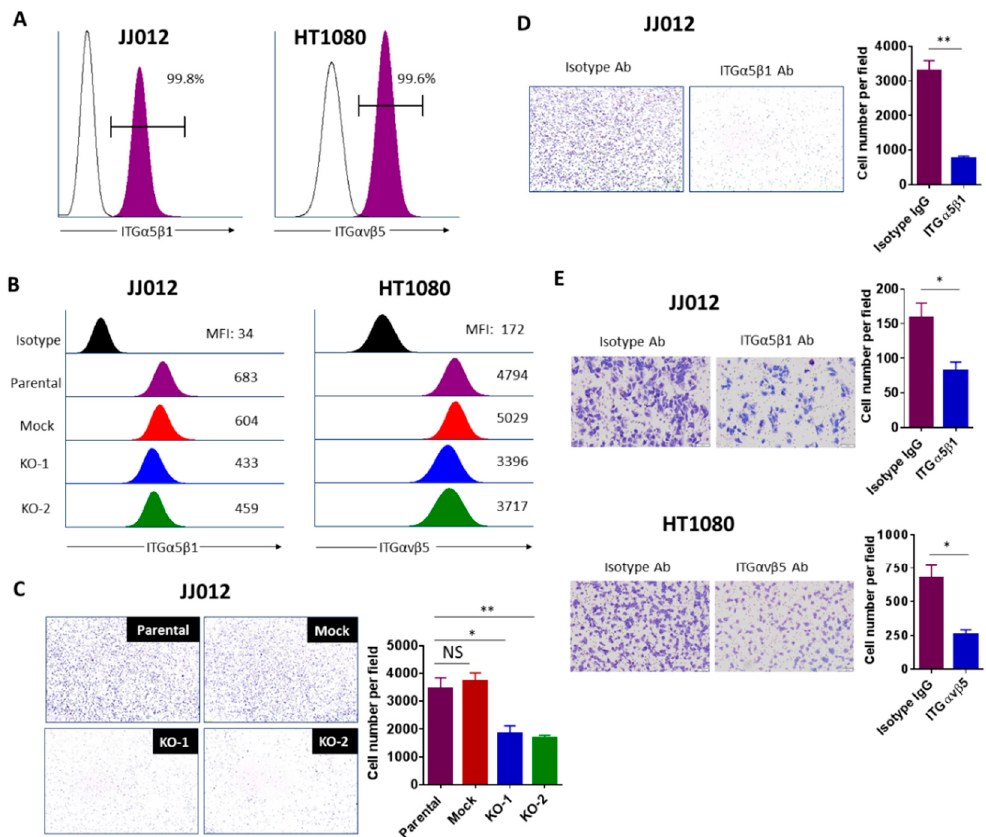
Figure 6. Integrins contribute to the tumorigenicity of chondrosarcoma cells. ( A ) Flow cytometry verifying high expression of ITG α 5 β 1 and α v β 5 on the surface of JJ012 and HT1080 cells, respectively. Representative FACS data from 3 independent experiments are shown. ( B ) Representative flow cytometry histogram demonstrating downregulated expression of ITG α 5 β 1 and α v β 5 in JJ012 and HT1080 IDH1 mut KO cells, respectively. Representative FACS data from three independent experiments are shown. ( C ) Cell adhesion assay of indicated JJ012 groups and ( D ) Cell adhesion assay of JJ012 cells pretreated with 1 µ g / mL ITG α 5 β 1-blocking antibody or its corresponding isotype control antibody. Cells were incubated on fibronectin-coated plates for 1–2h followed by washing, fixing, and staining. Cell adhesion was evaluated by counting the average number of attached cells per field. Results are shown as the mean ± SEM of triplicate cultures and are representative of three independent experiments. Original magnification, 10 × . ( E ) Transwell migration assay of cells pretreated with 1 µ g / mL ITG α 5 β 1 (JJ012) or 10 µ g / mL ITG α v β 5 (HT1080) blocking antibodies and their corresponding isotype controls for 1–2 h. The migrated cells were counted and the average cell number per field was determined. Data indicate mean ± SEM of triplicate cultures and are representative of three independent experiments. Original magnification, 20 × (scale bars: 100 µ m). * p < 0.05, ** p < 0.01.